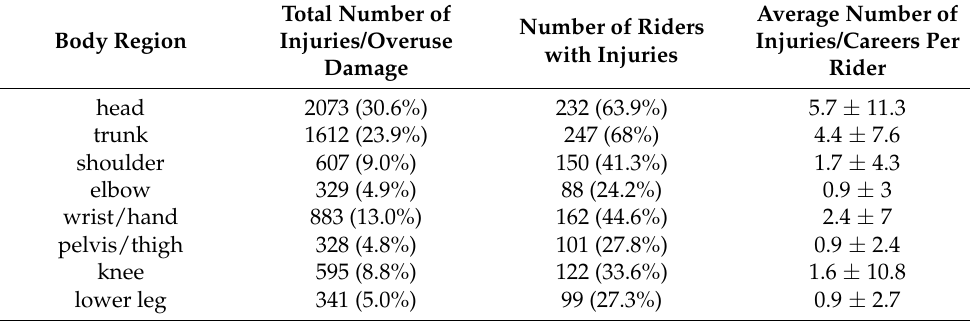
Figure 4. Number of trunk injuries by performance level ever (blue) and on 1000 h (red). The number of injuries to the remaining body regions are shown in Table 2. Table 2. All recorded injuries to the remaining body regions are